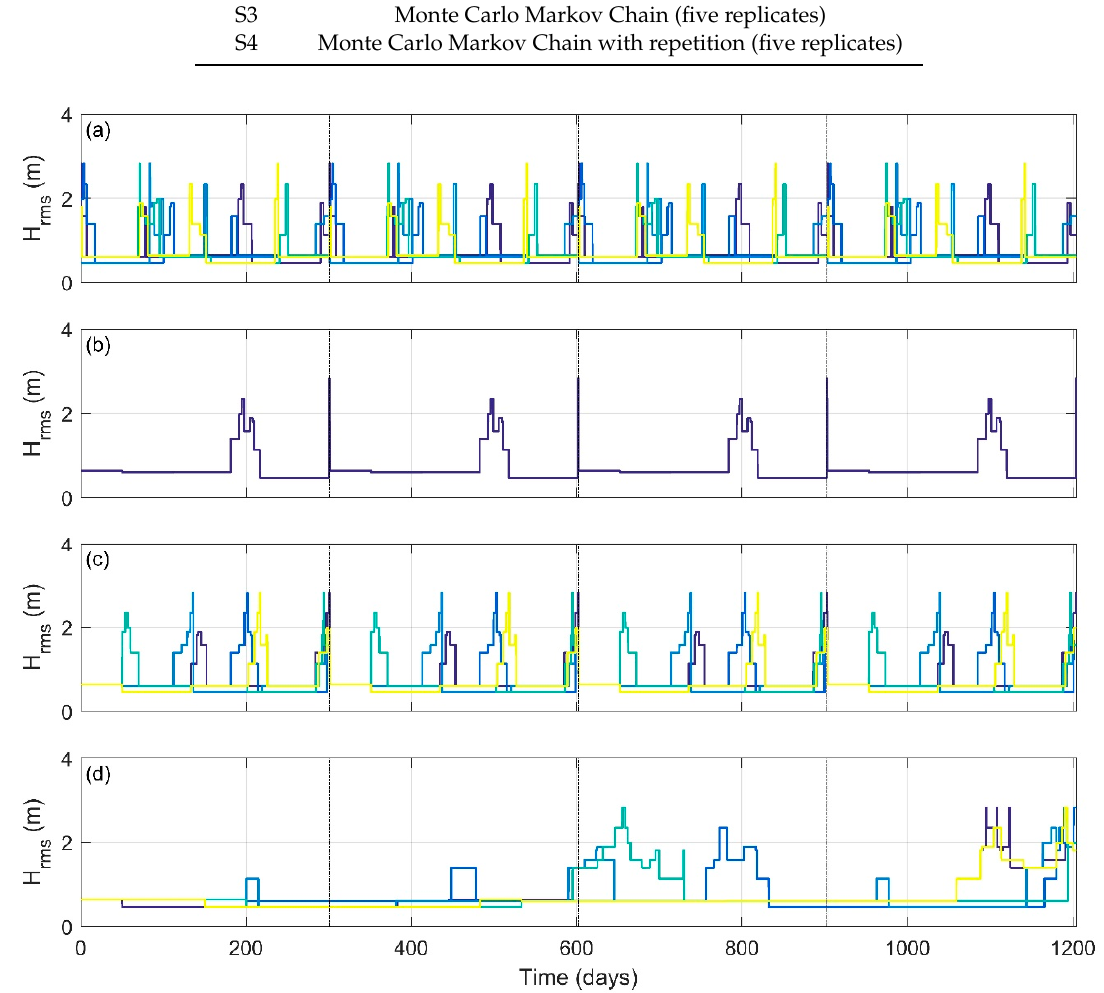
Figure 5. Wave height time-series of the reduced wave climate by the Sediment Transport Bins method (STBM) with a duration of 301 days sequenced by random ( a ), Markov Chain ( b ), Monte Carlo Markov Chain ( c ), and Monte Carlo Markov Chain with repetition ( d ) methods with k = 12. The colored lines represent the five repetitions. The dashed line marks the duration of each reduced wave climate.